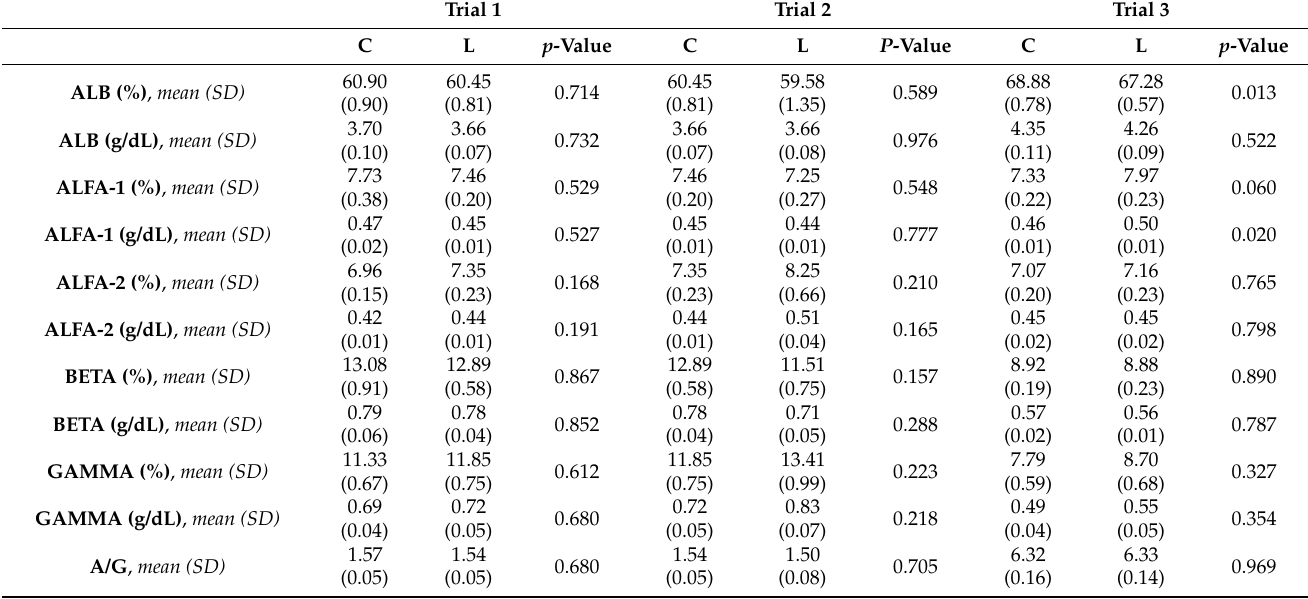
Table 4. Electrophoresis of serum proteins between control and probiotic group of trials 1,2 and 3. Trial 1 Trial 2 Trial